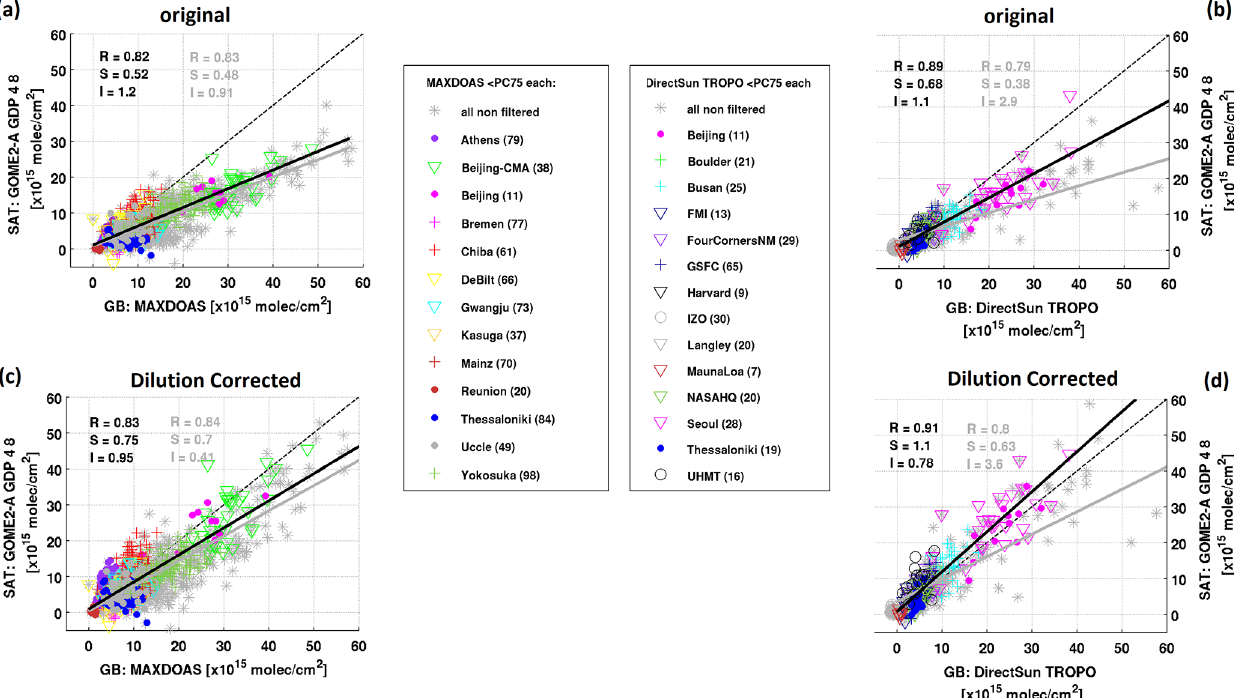
Figure 11. Scatterplot of monthly mean GOME-2A GDP 4.8 NO 2 columns versus UIPP ground-based stations (MAX-DOAS instruments in (a, c) and direct sun instruments in (b, d) ). Panels (a, b) present the original comparisons, and panels (c, d) those after applying the dilution correction. Calculations of the monthly mean values are performed after removal of the daily ground-based points larger than the 75 percentile of each station dataset. The monthly means without the filtering are presented in grey to illustrate the impact, and the number of remaining months for each station is given in brackets in the legend. Linear regression values are shown on each